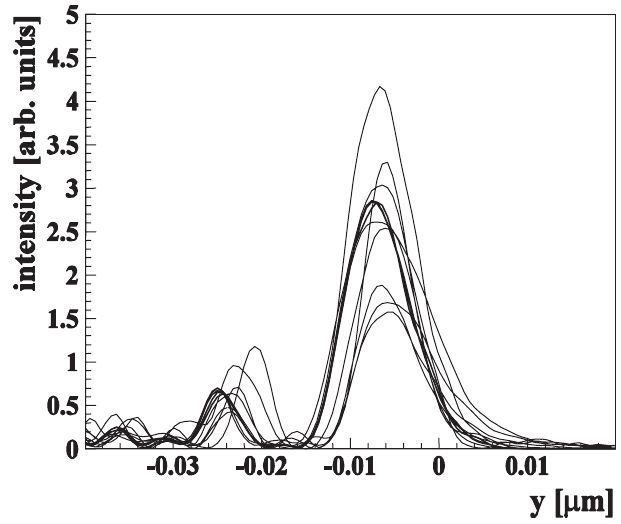
FIG. 5. Vertical cut in the focal plane for the geometry de- scribed in the text. The thick lines which are nearly identical correspond to source-mirror distances of 0.5, 1.0, and 1.5 m, respectively. The thin lines are the results for distances of 2.0, 3.0, 4.0, 5.0, 6.0, 7.0, 8.0, and 9.0 m.